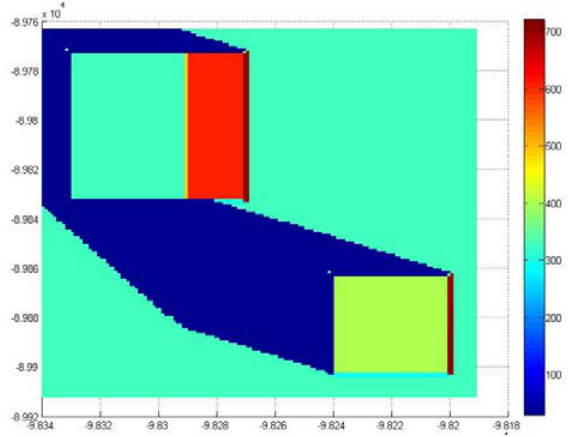
Figure 3: Direct radiation map for March, 21 st at 7 a.m. for the synthetic data set [W/m 2 ].